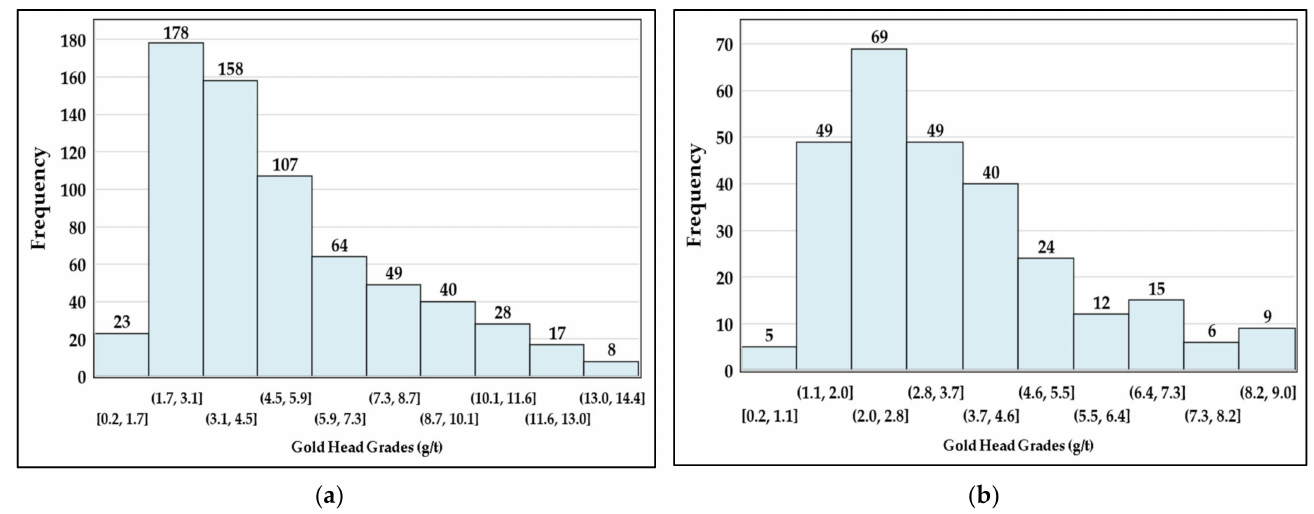
Figure 8. Gold head grade histograms for ( a ) the HCC geometallurgical unit and ( b ) the LCC geometallurgical